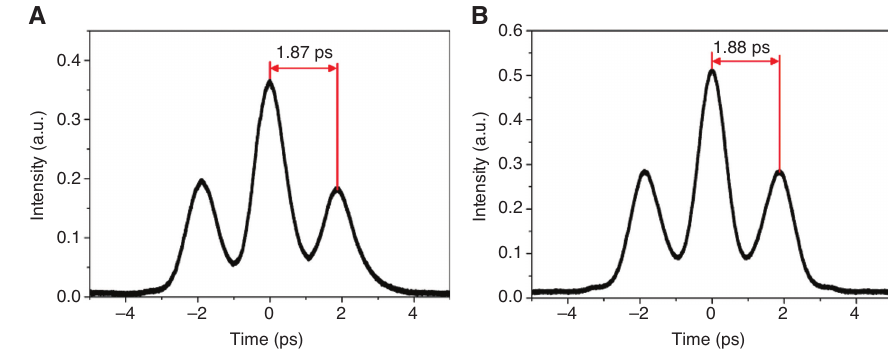
Figure 4: The autocorrelation trace of the coexistence state at (A) 105 mW; (B) 200 mW. In addition, the autocorrelation traces basically remains unchanged with the increment of pump power, as depicted in Figure 4B.